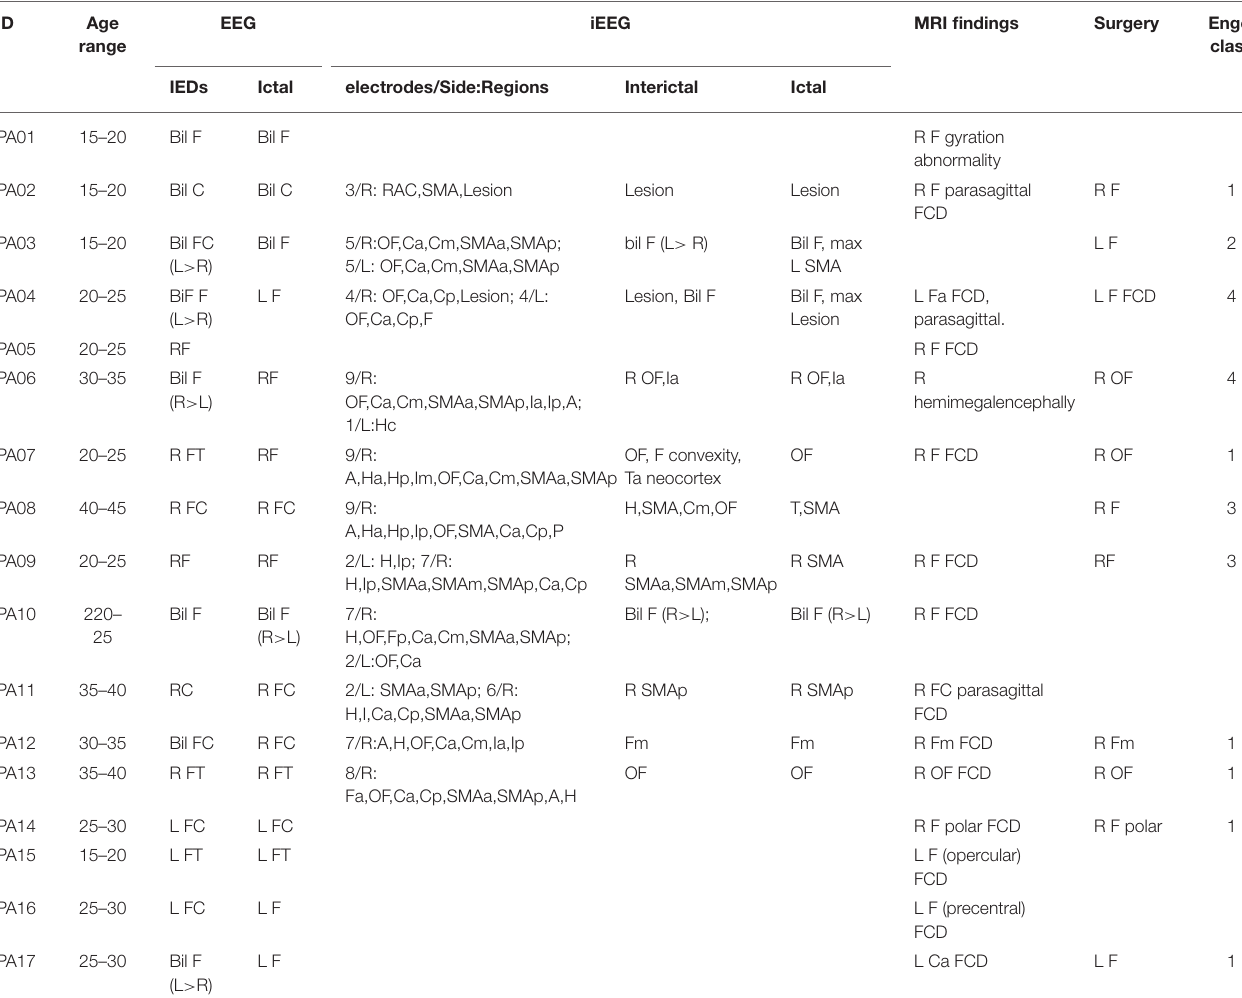
TABLE 1 | Epidemiological and clinical